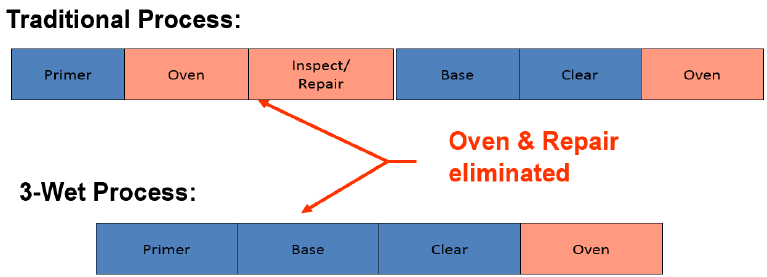
Figure 12. Existing and 3 ‐ wet processes of the primer coat.